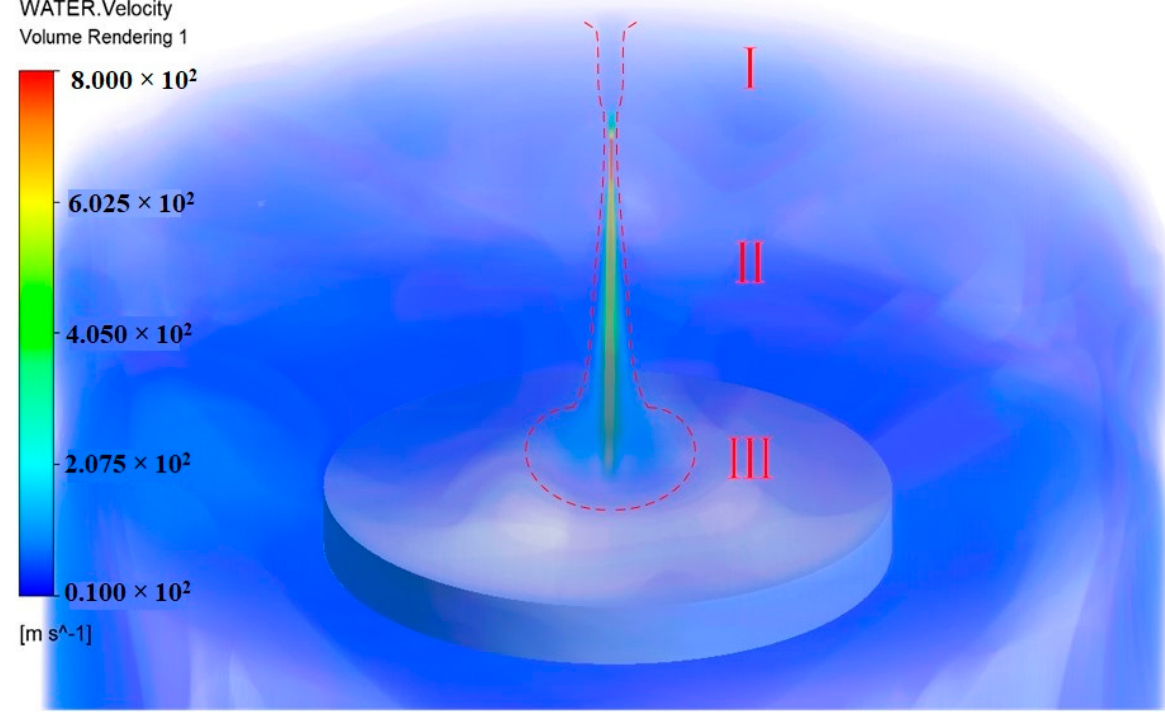
Figure 5. Cloud map of the spatial distribution of velocity field of an ultrahigh pressure water jet impinging on the target.